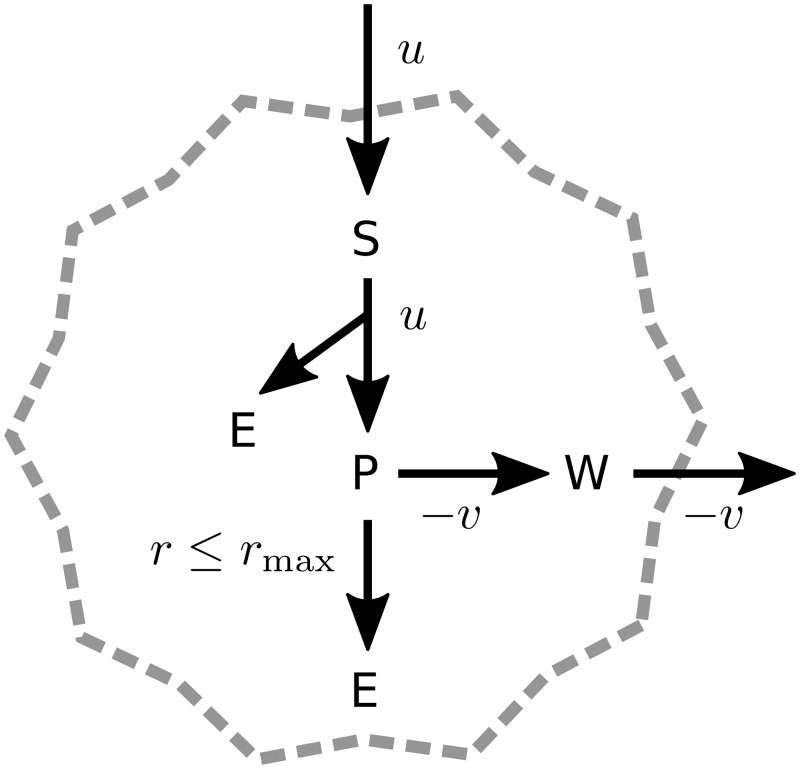
Diagram of a simple metabolic network.A primary carbon source S is consumed by the cell at a rate u ≥ 0. It is processed into an intermediate P, generating NF energy units per unit S consumed. The intermediate P can be excreted in the form of a waste product W (rate −v ≤ 0), or it can be completely oxidized (rate r ≥ 0) generating an additional NR energy units (NR ≫ NF). The respiration rate is capped, r ≤ rmax.